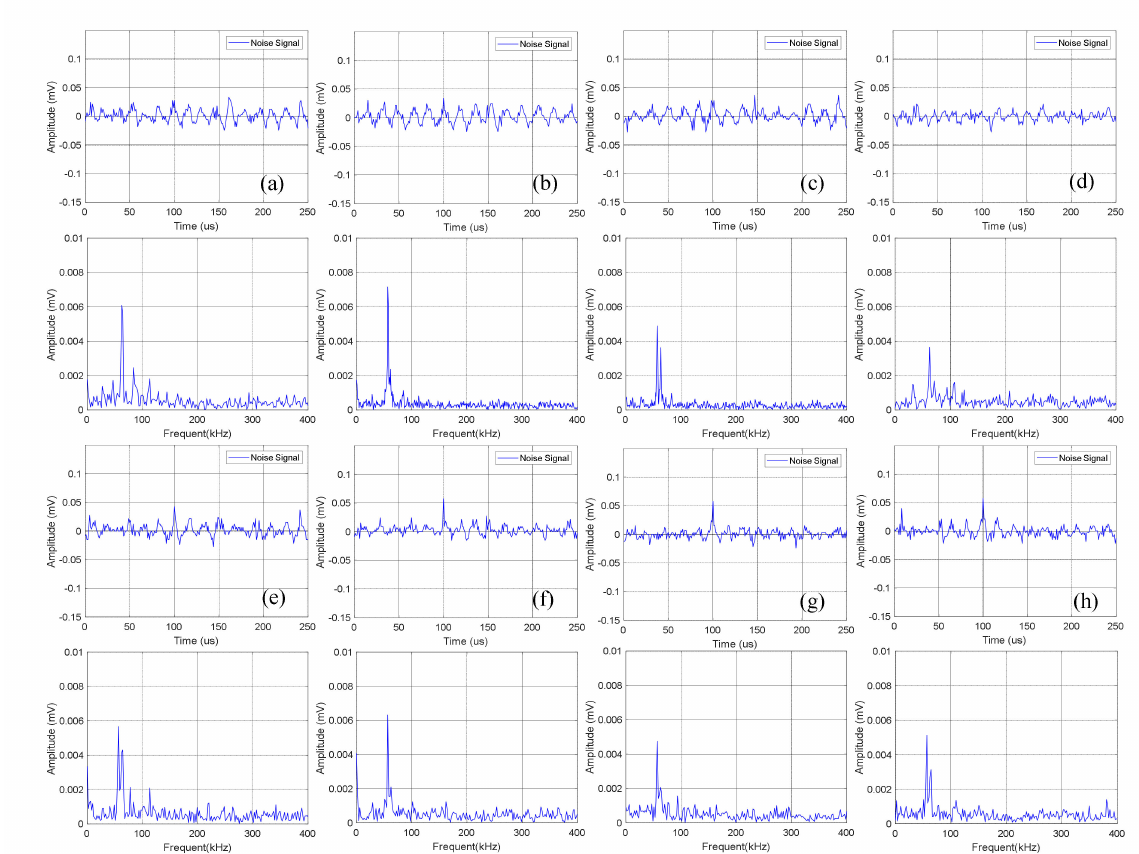
Figure 6. Time domain-frequency domain diagram of 0–600 cycles of charge of Group A batteries: ( a ) 0 cycles; ( b ) 10 cycles; ( c ) 100 cycles; ( d ) 200 cycles; ( e ) 300 cycles; ( f ) 400 cycles; ( g ) 500 cycles; ( h ) 600